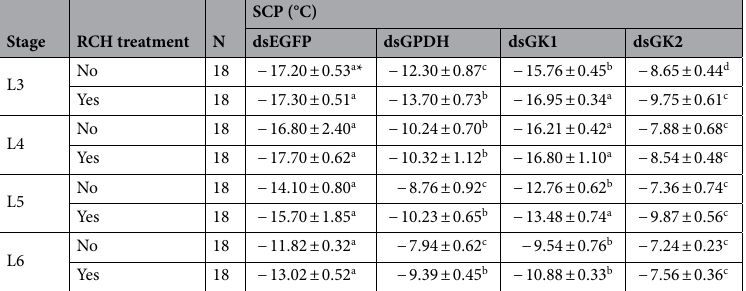
Table 3. Changes in supercooling points of Spodoptera frugiperda (third to sixth instar) after RNAi and rapid cold hardening treatment. All dsRNAs specific to target glycerol biosynthesis genes were constructed at ~ 300–400 bp and injected to each L5 larva at 3 μg. Control RNAi (‘dsEGFP’) was injected with dsRNA specific to EGFP gene. The supercooling point was measured after RNAi injection (48 h post injection) and RCH treatment (5 °C for 6 h). Each treatment was replicated three times with 18 individuals per replication. Different superscript letters indicate significant difference between means for each SCP (Type I error = 0.05, LSD test).